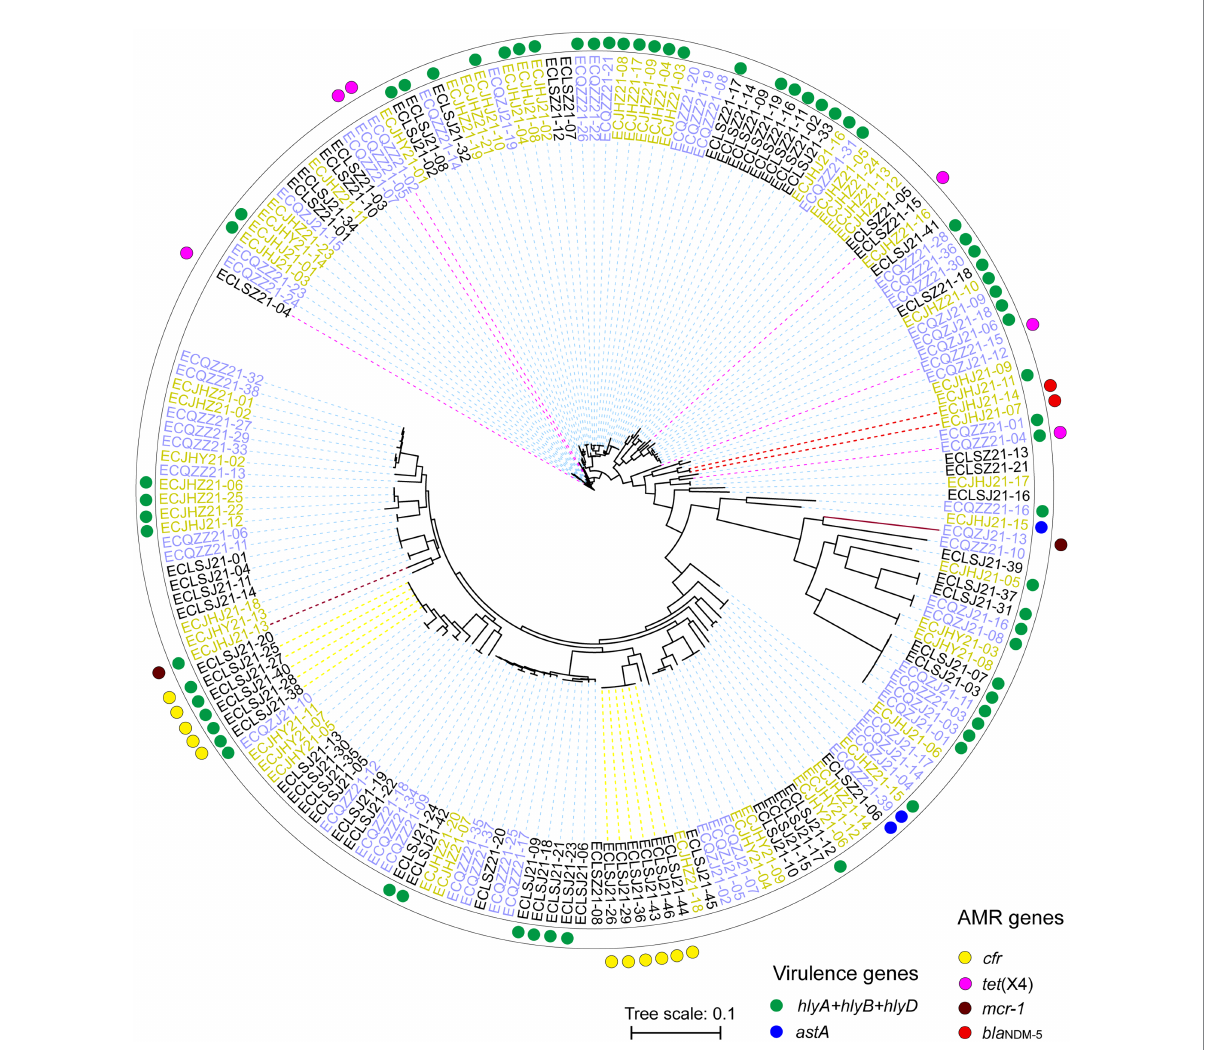
FIGURE 8 Phylogenetic SNP tree of E. coli strains with whole genome sequences. Red and blue dots indicate different virulence genes carrying strains, and yellow, pink, brick and red indicate different AMR genes carrying strains. The strains with different colors represent three different